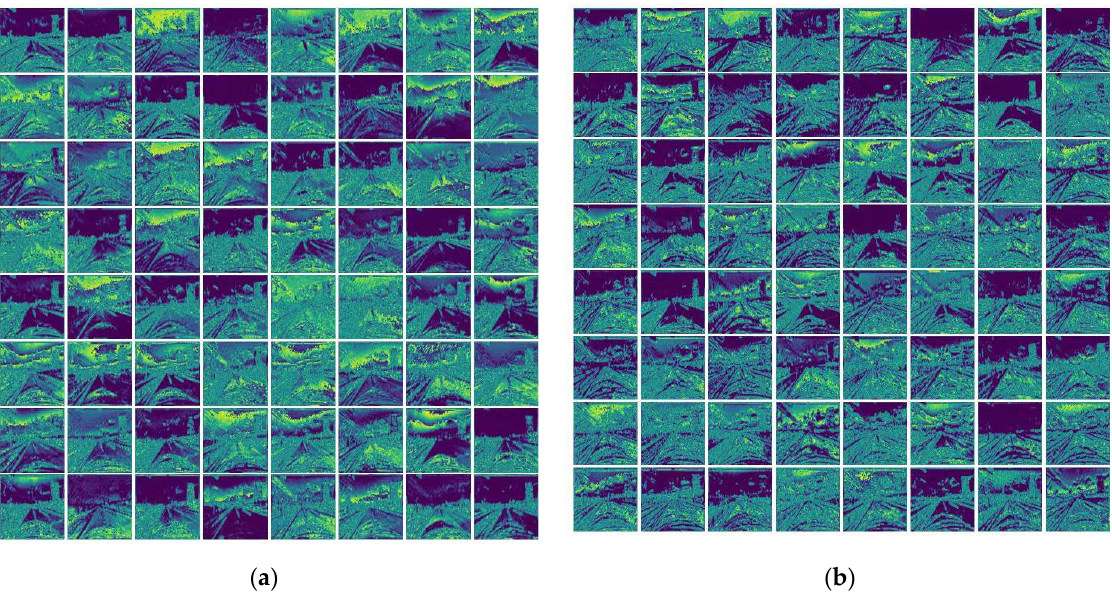
Figure 8. The comparison of the feature maps generated from the first convolution layer: ( a ) the proposed method; ( b ) deeplabv3plus with RESNET18.